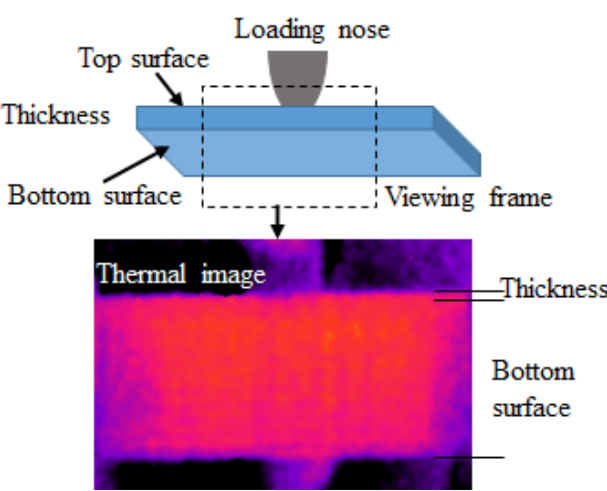
Figure 7. Sketch of quasi ‐ static bending configuration and viewing frame.